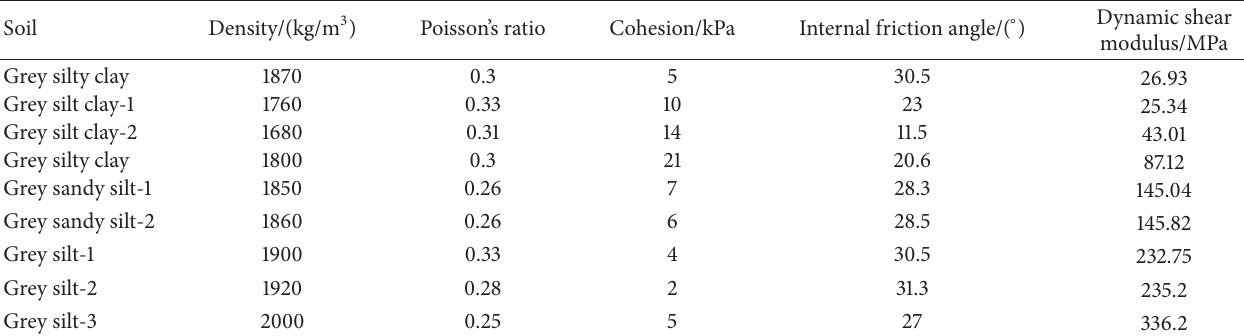
Table 2: Material properties of foundation.